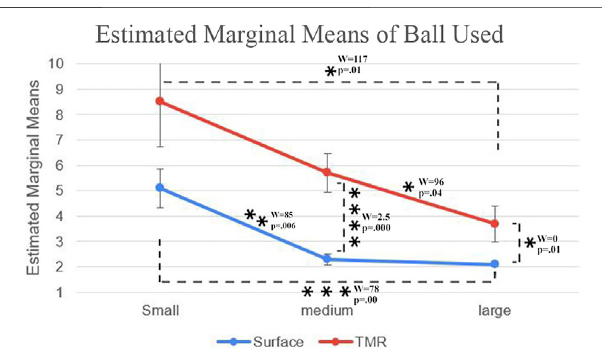
FIGURE 8 | Number of balls used in each condition (* = p < 0.05, ** = p < 0.01, *** = p < 0.005, **** = p < 0.001).